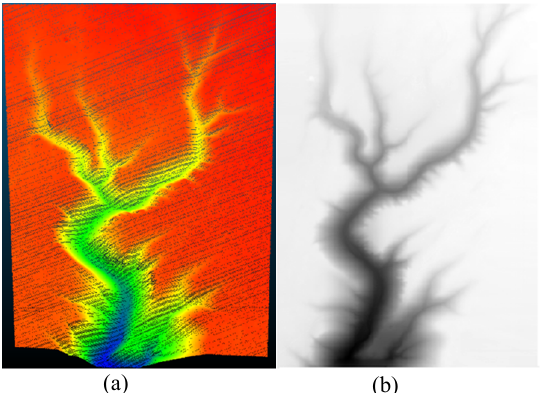
Figure 4. The show of test data. (a) the 3D point cloud; (b) the image